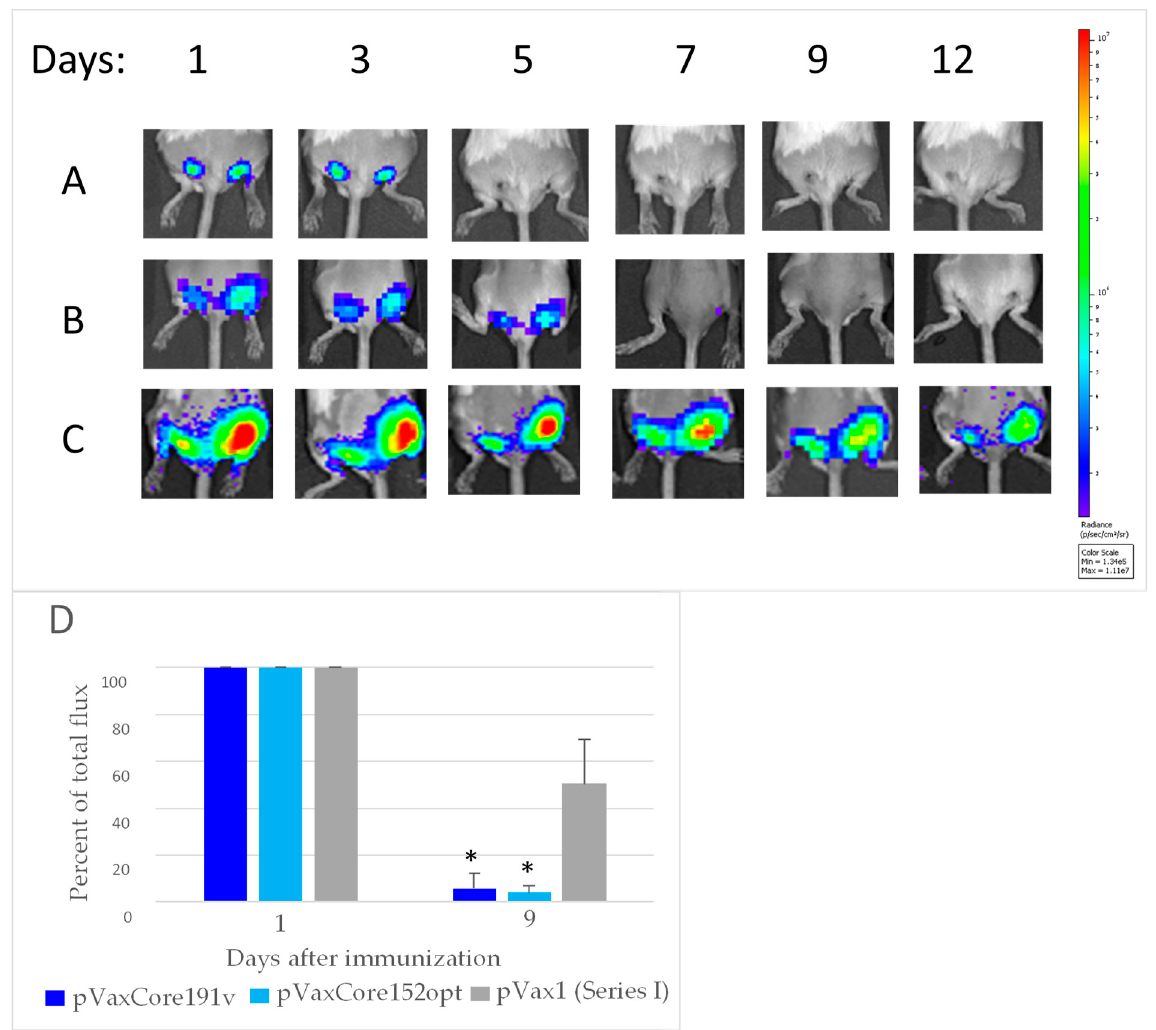
Figure 7. Loss of bioluminescence signal from the sites of boost with HCV core genes co-delivered with reporter plasmid encoding Luc. Mice were boosted with DNA encoding Core191v ( A ), Core152opt ( B ) or empty vector ( C ); average loss of BLI signal from day 1 to day 9, in % + STDV ( D ). Figures on the top show days after injections. Color scale to the right of the images in panels A-C represent signal intensity (photons/sec). * p < 0.05 between Core191v, Core152opt and vector immunized mice, F-test (Statistica Tibco 13.5).